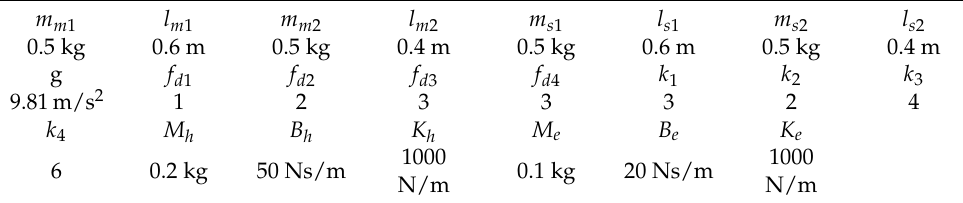
Table 2. Master–slave robot parameters, operator and environment